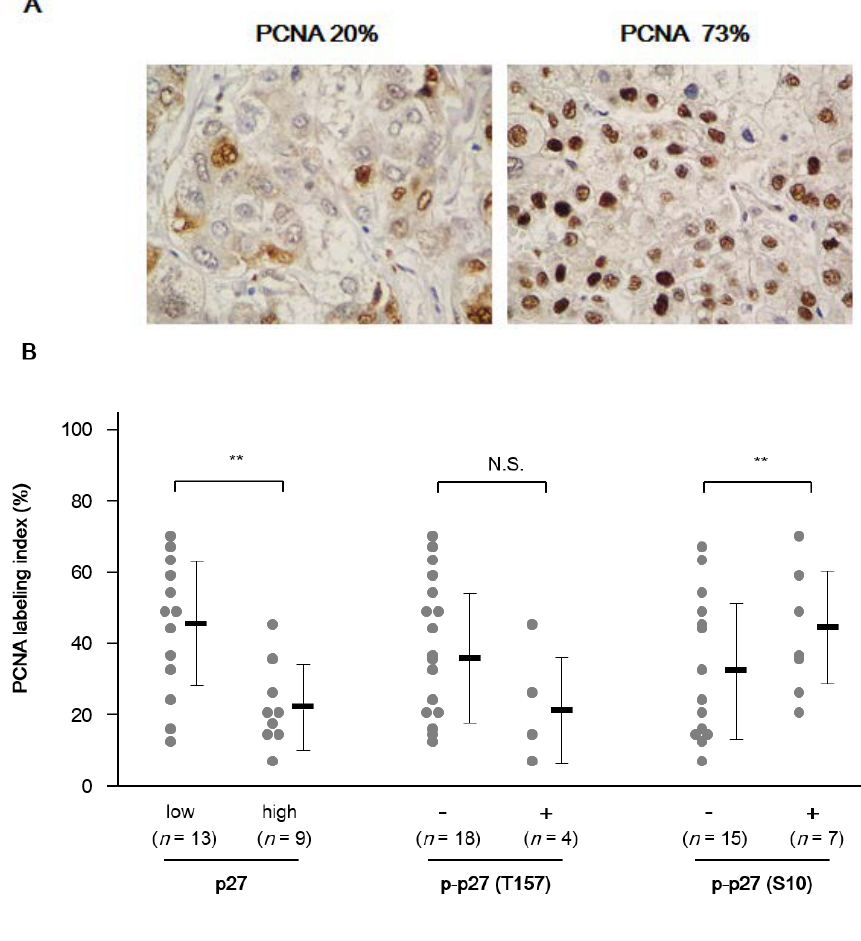
Figure 3. Correlation between the PCNA labeling index and p27 status in NASH-related HCC. ( A ) Representative images of immunostaining for PCNA in HCC (original magnification: ×100); and ( B ) Dot plots of the labeling index of PCNA in the subgroups according to different expression of p27 and phospho-p27. The horizontal bar depicts the mean value and the vertical bars indicate the standard deviation. p -values were obtained by the Mann-Whitney test. N.S., not significant; ** p <